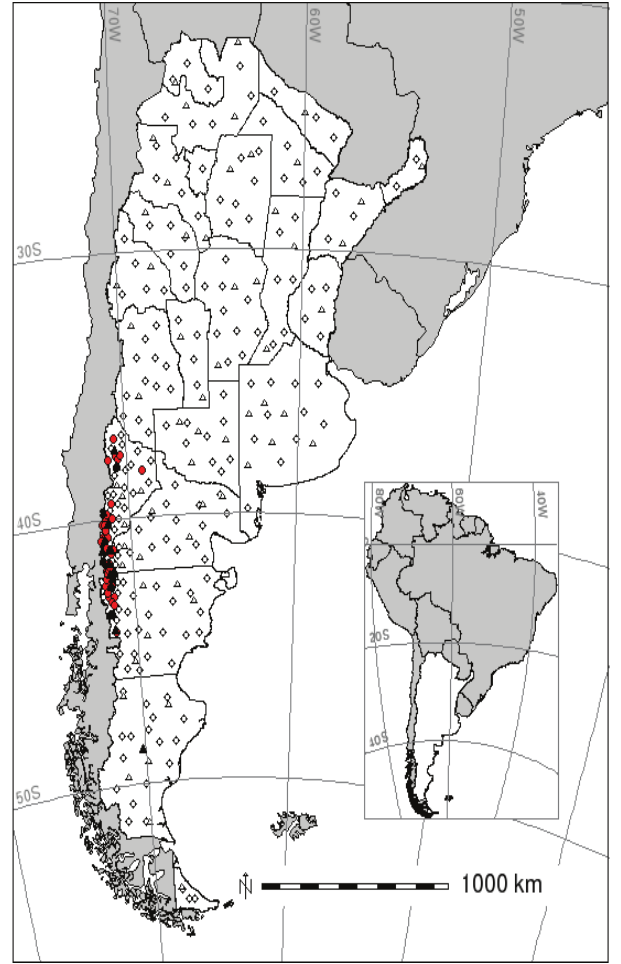
Figure 1. Training and test samples for the occurrence of hantavirus pulmonary syndrome (HPS) in Argentina. Training data in circles; test data in triangles. Filled symbols are the presence and empty symbols the absence of